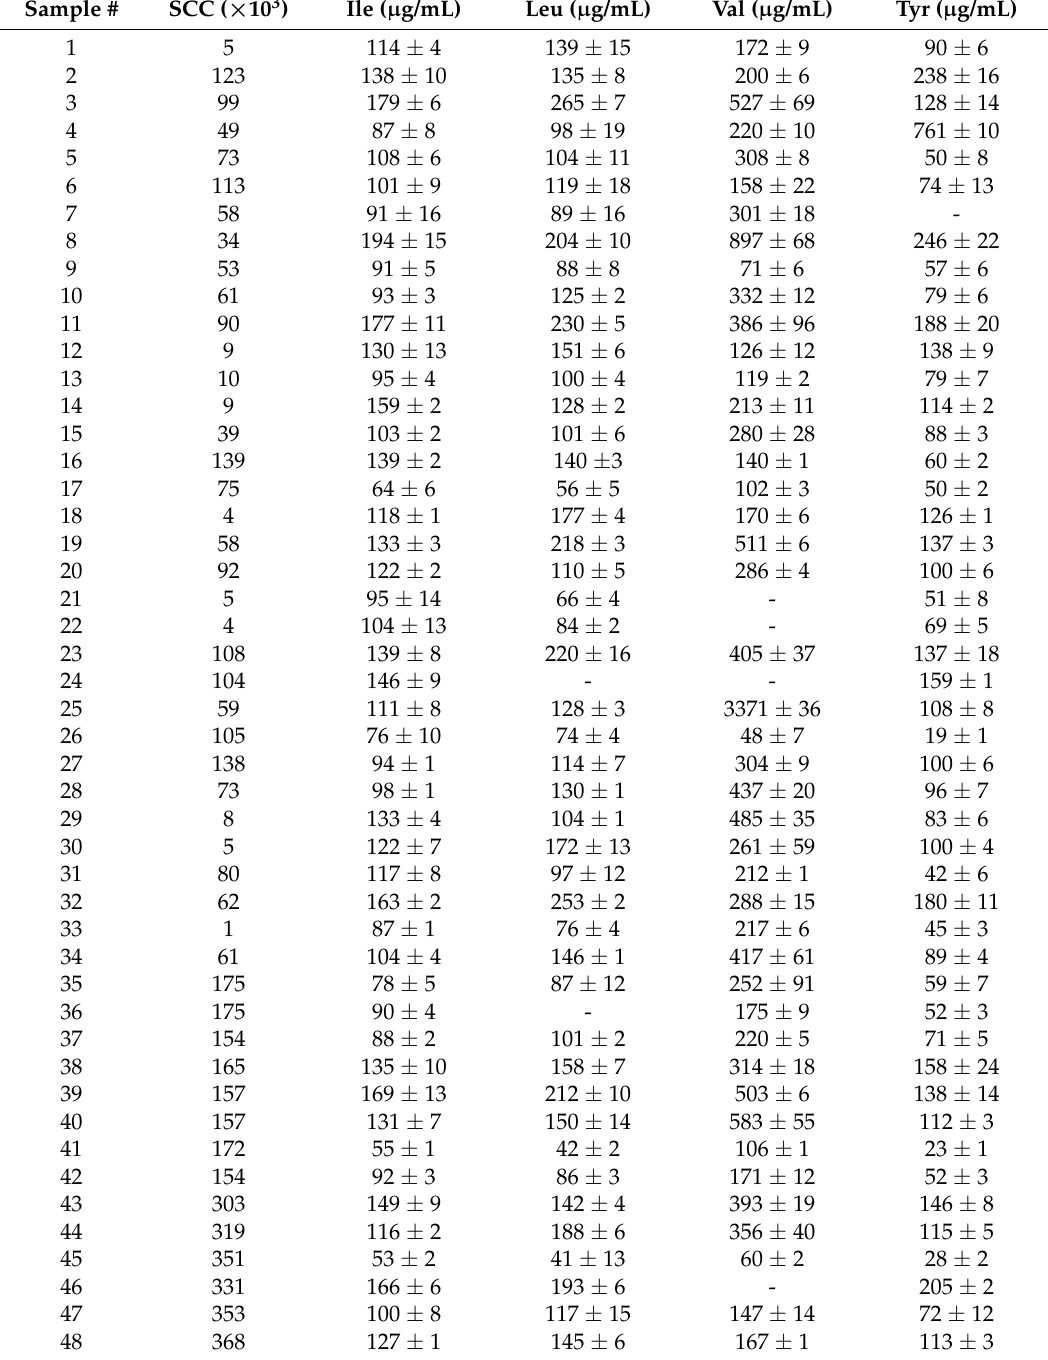
Table 1. Content values of selected amino acids in Group I, along with somatic cells count (SCC)